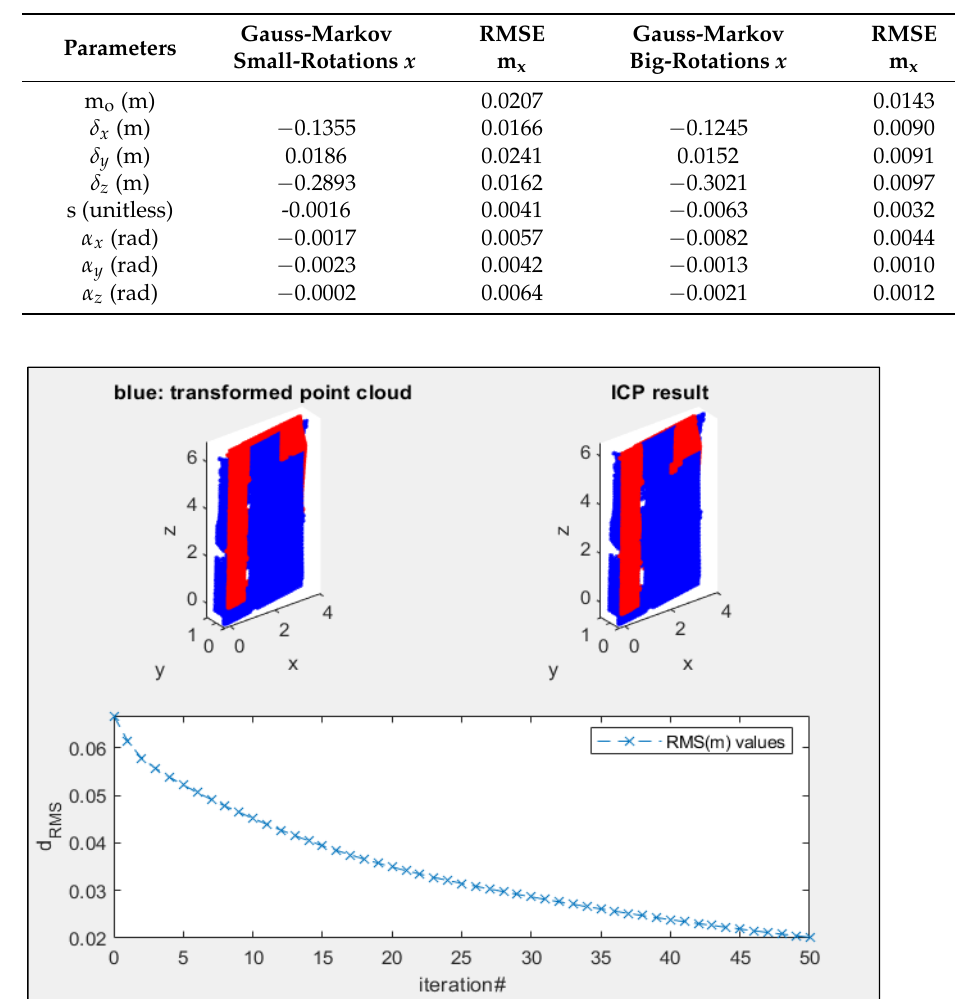
Figure 23. Building facade: results obtained from iterative closest point (ICP) algorithm where the TLS and MLS point clouds’ keypoints identified and matched by the new algorithm are used.